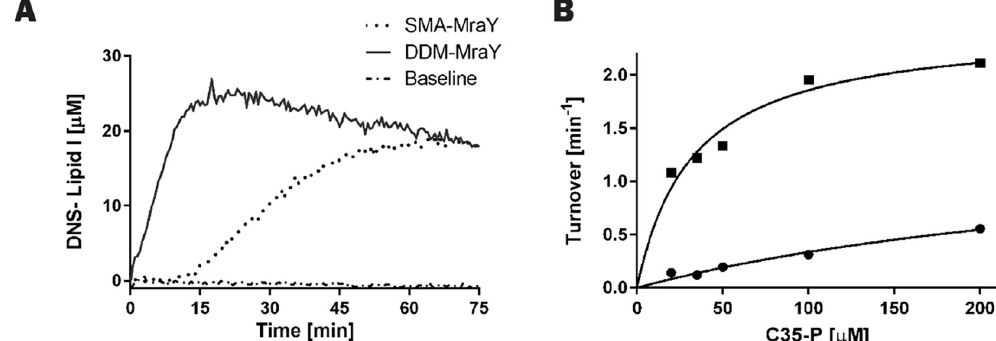
Fig 7. Kinetic analysis of Lipid I synthesis with MraY. (A) DNS-Lipid I production from 25 μ M DNS- UDP-Mpp and 400 μ M C35-P (in 0.5% Triton X-100) catalyzed by DDM-MraY (10 nM) or SMA-MraY (10 nM). Concentration of DNS-Lipid I was converted from the fluorescence signal as previously described (20). (B) Turnover rate of DNS-Lipid I production from 25 μ M DNS-UDP-Mpp at several C35-P concentrations for DDM-MraY ( ■ ) and SMA-MraY (•).